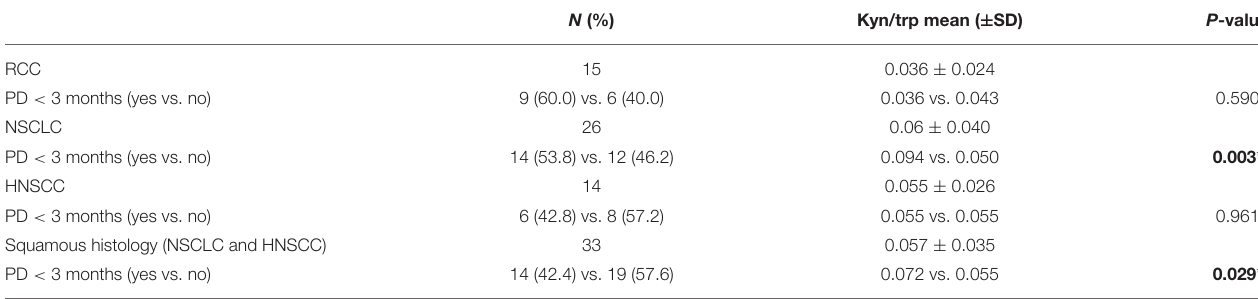
TABLE 2 | Association between kyn/trp ratio, early progression, and primary